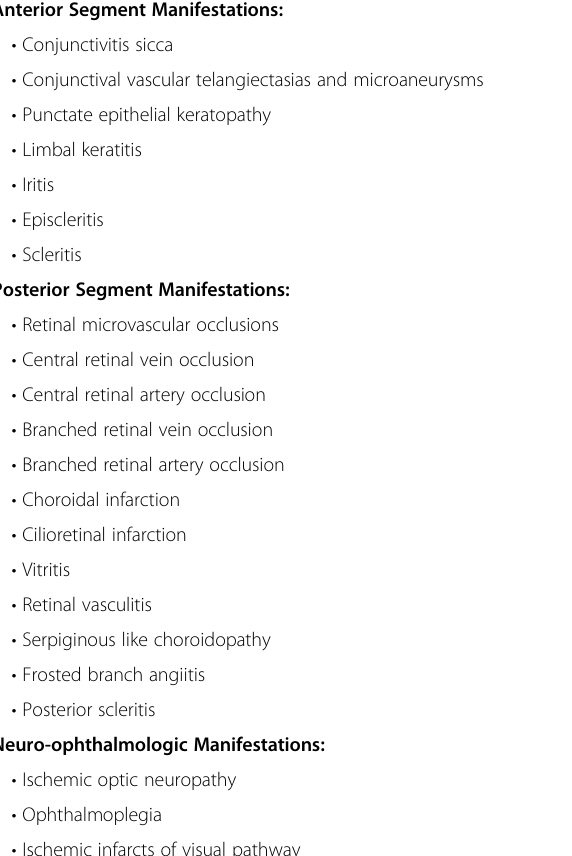
retinal vasculitis, episcleritis, and scleritis have been de- scribed as clinical findings of APS [32, 34].